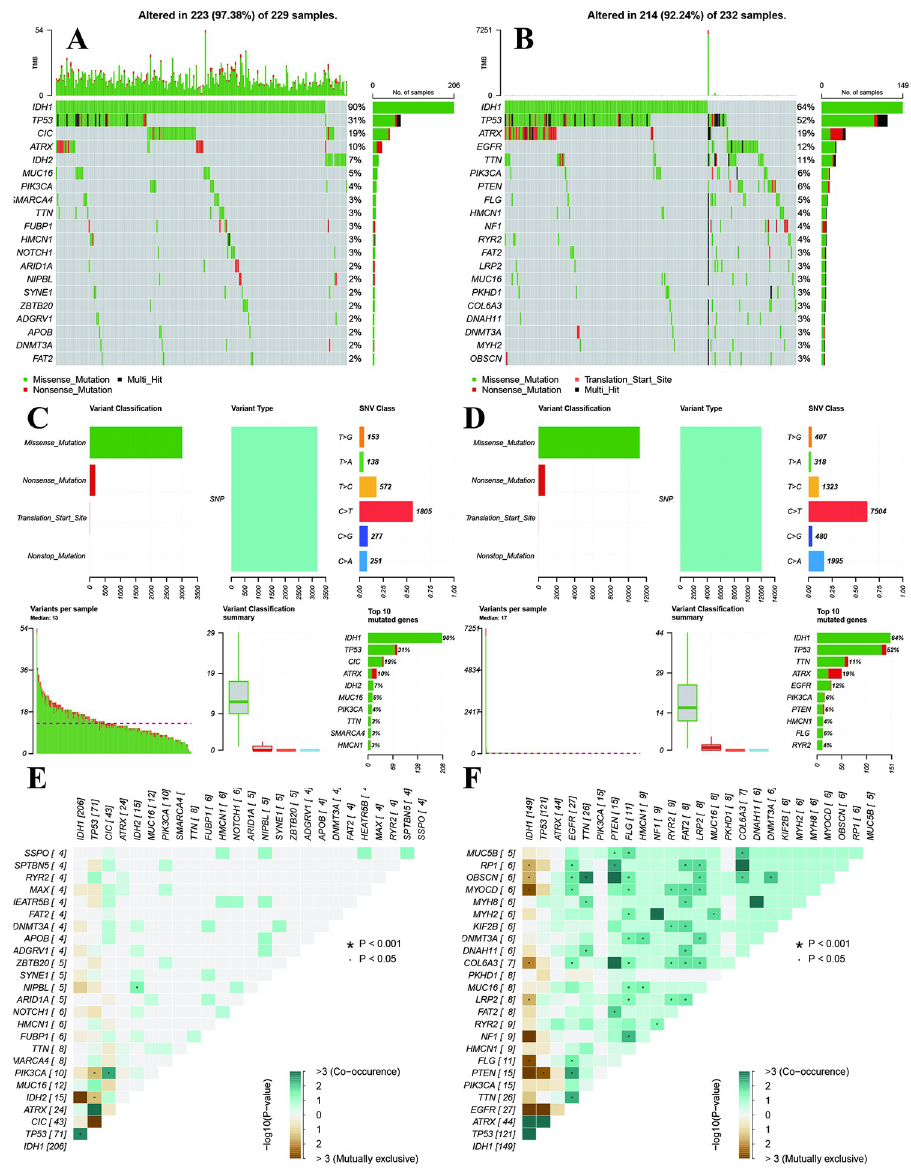
Fig 7. Gene alterations levels between high- and low-risk groups. A and B: Top 20 gene alterations frequencies in high- and low-risk groups. C and D: Variant classifications of high- and low-risk groups. E and F: Co-occurrence and mutually exclusive genes of high- and low-risk